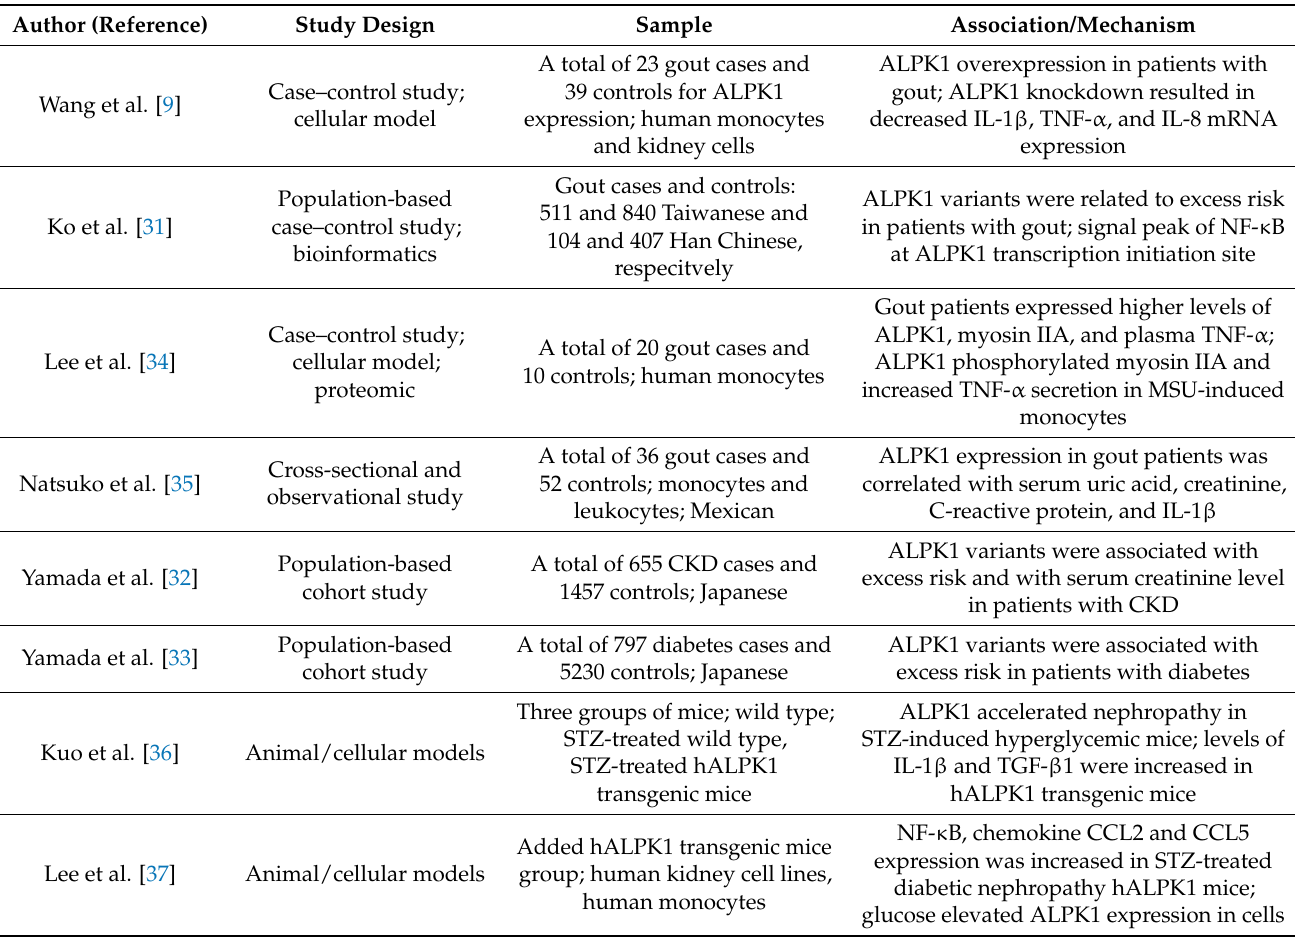
Table 2. Evidence of the association between ALPK1 and gout, chronic kidney disease, and